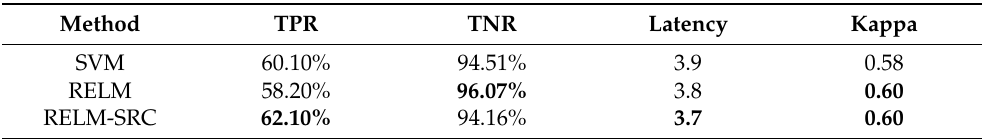
Table 7. Metrics for the ProDiMES cruise testing dataset, averaged for abrupt and rapid faults (Stage 1 and Configuration 3, comparison with